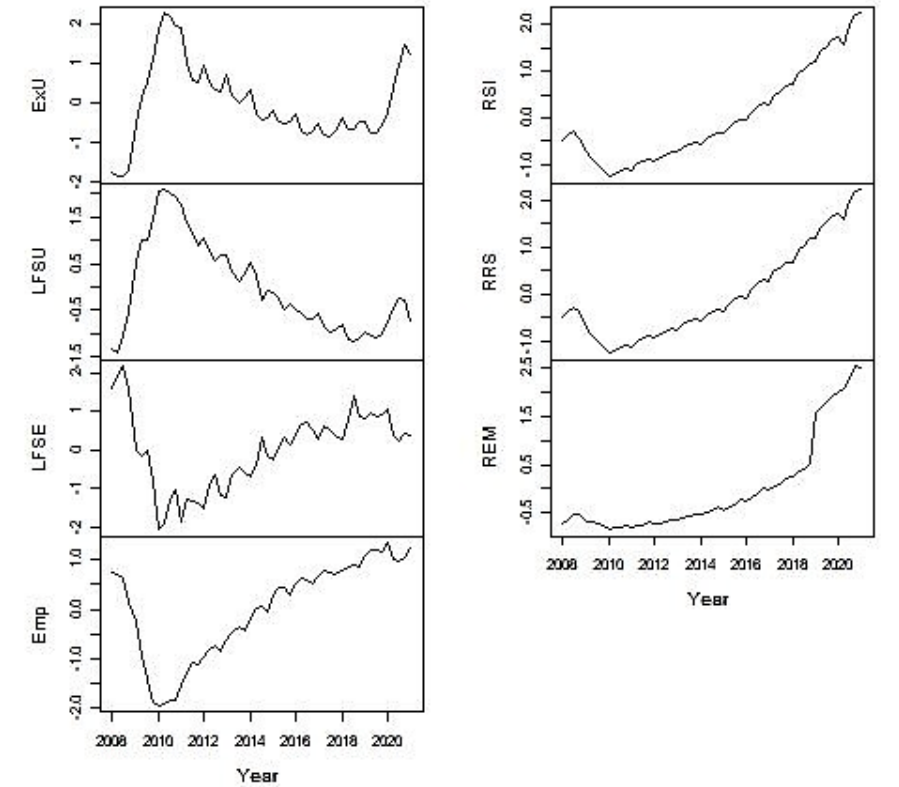
Figure 3. Time series after the exclusion of polynomial trends and standardization.